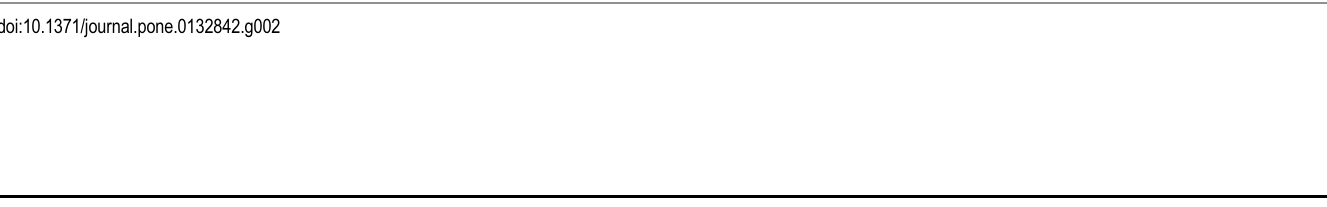
PLOS ONE | DOI:10.1371/journal.pone.0132842 July 29,